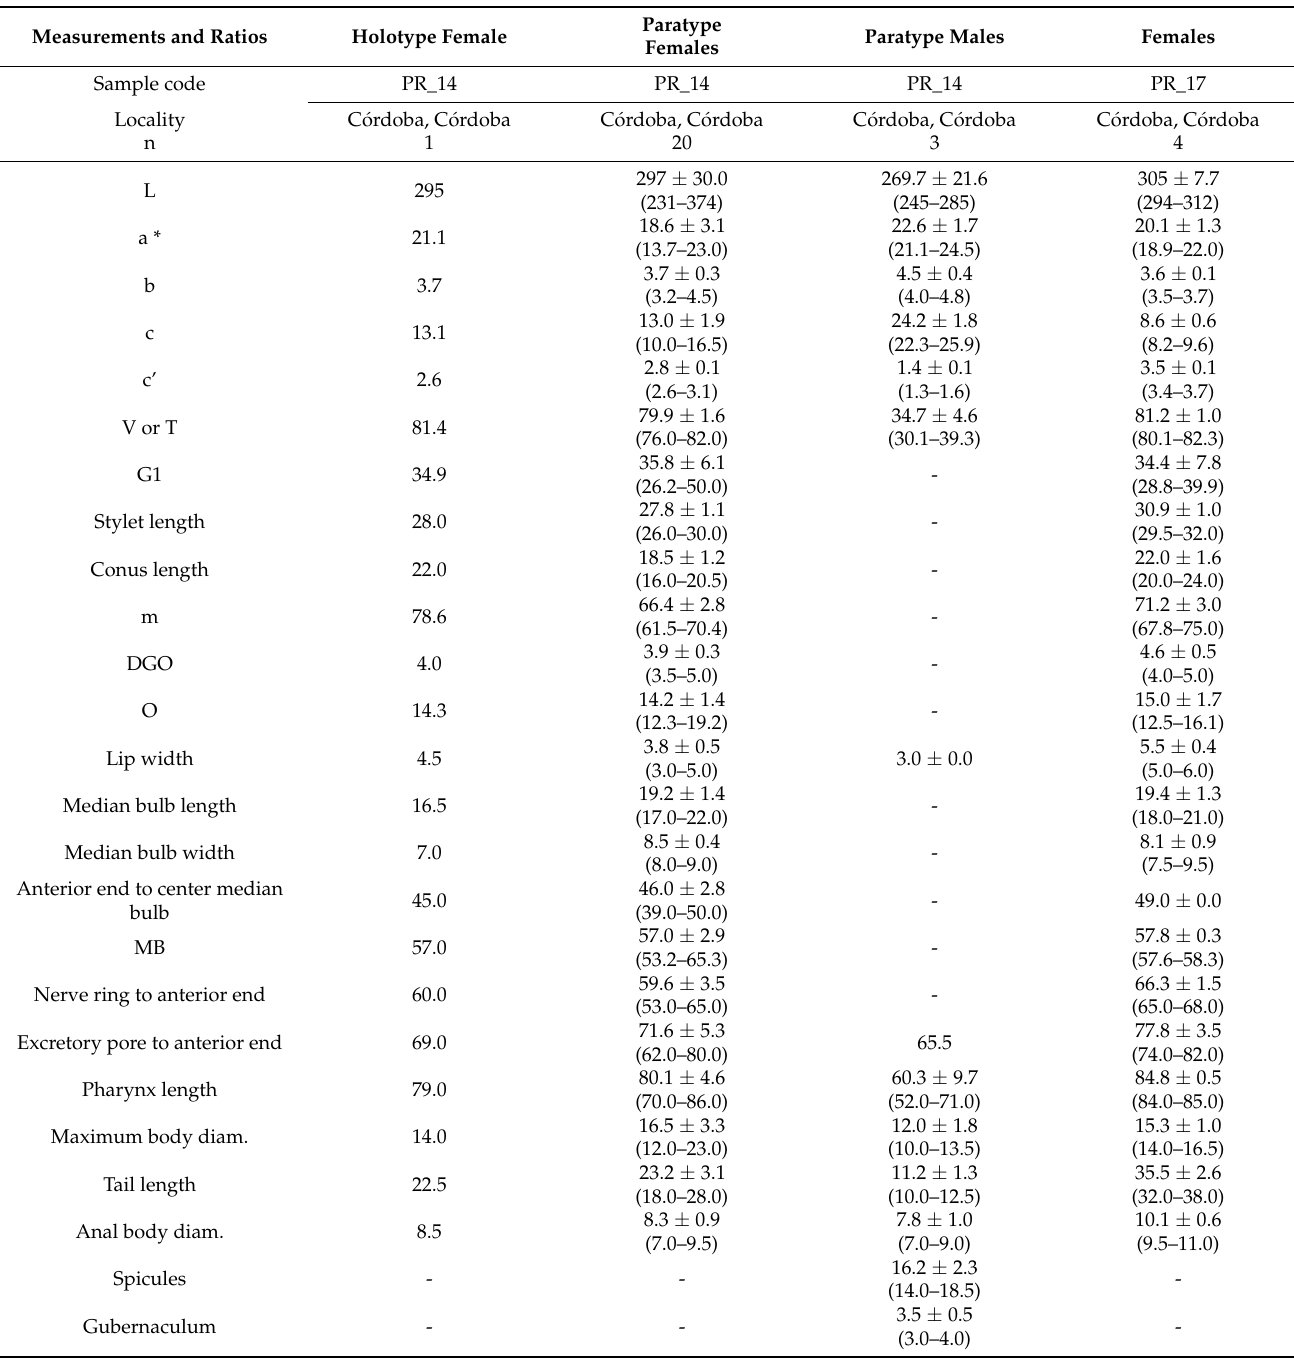
Table 4. Morphometrics of Paratylenchus pedrami sp. nov. paratype females, males and other population from Spain. All measurements are in µ m and in the form: mean ± s.d.